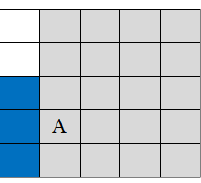
Figure 3. Radial Basis Function (RBF-Kriging) algorithm interpolated diagram (blue points).